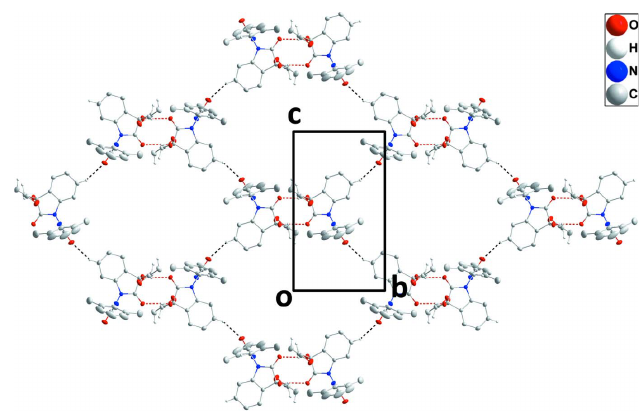
Figure 2 A plan view of a portion of one layer viewed along the a -axis direction. interacting hydrogen atoms are omitted for clarity.